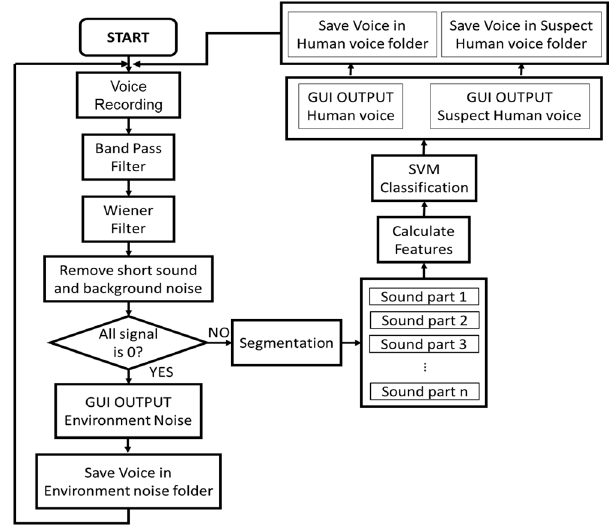
Figure 2. SVM classification for human voice and environment noise.